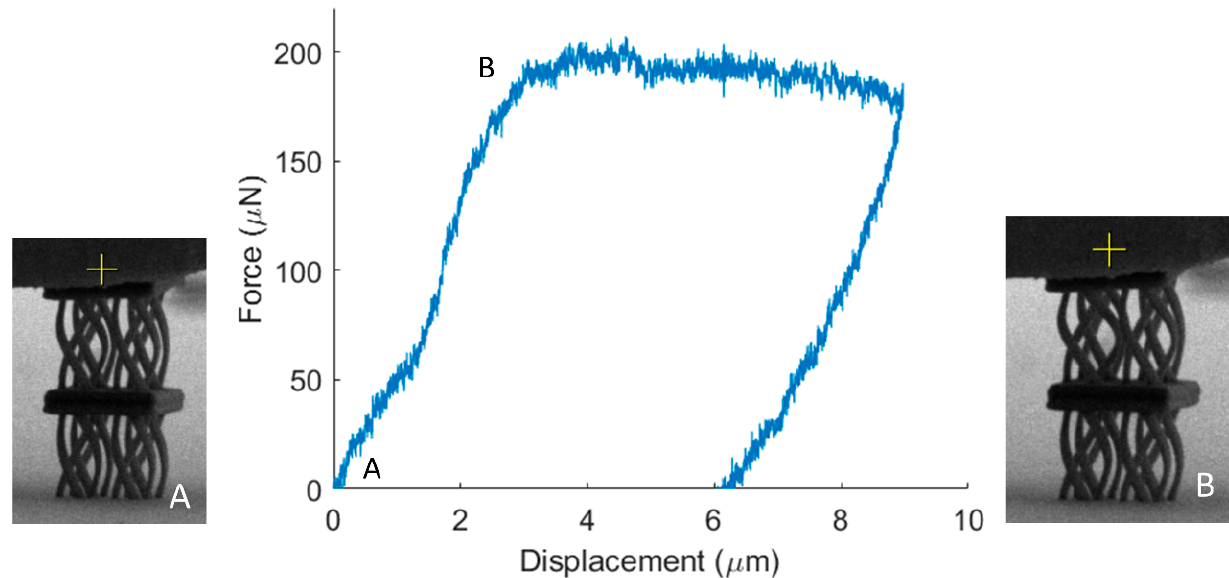
Figure 8. Mechanical testing of the twisting mechanical metamaterial. During the compression of the structure, the unit cell rotates leading to densification through contact of the curved members and a plateau in the response of the structure.